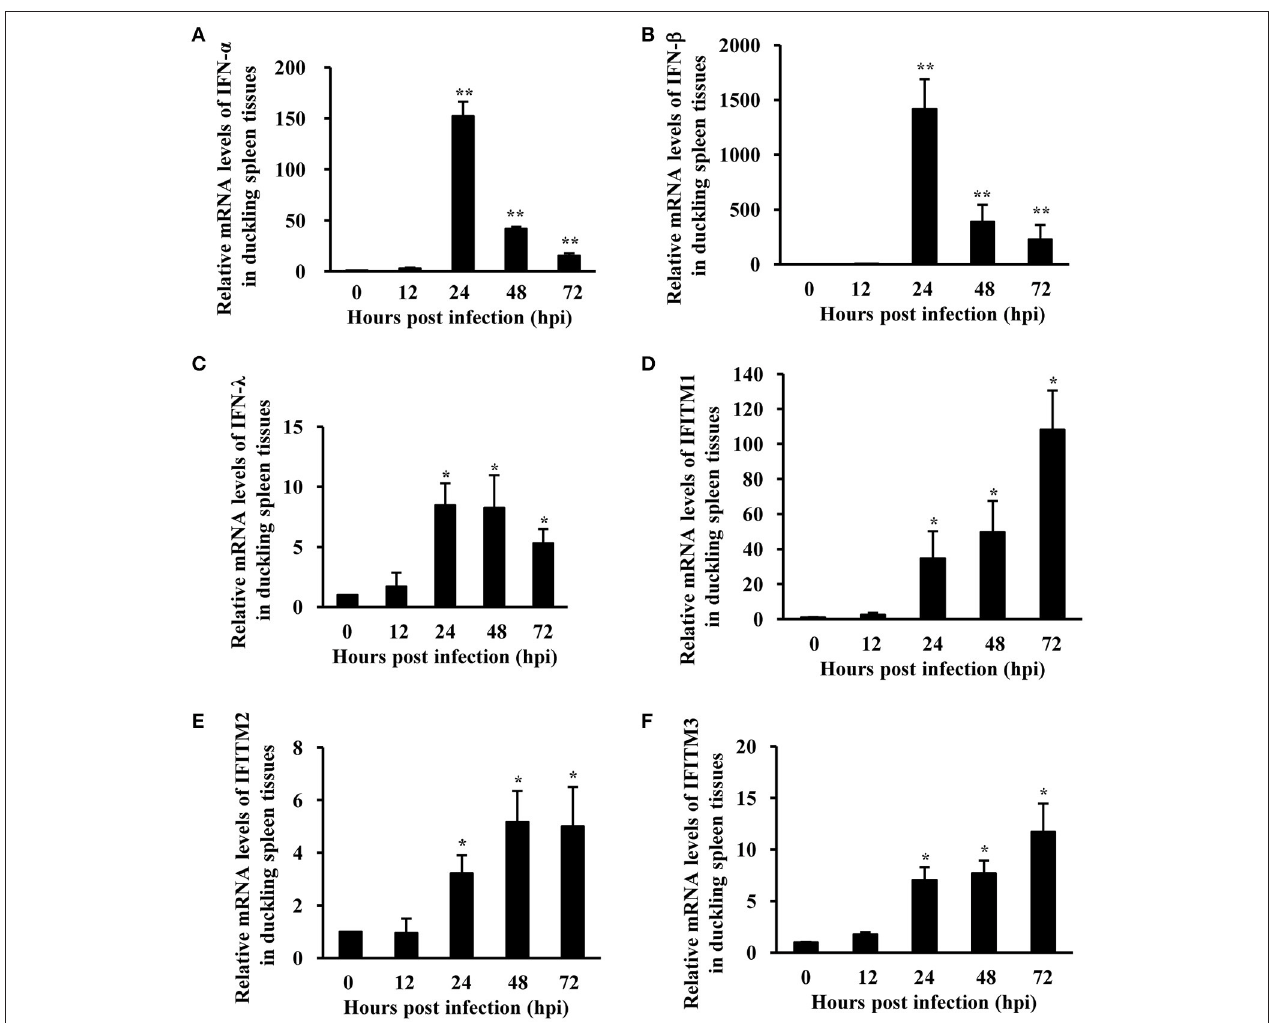
FIGURE 2 | Expression of IFNs and IFITM family is strongly upregulated in duck in response to ATMUV infection. Twenty five 7-day-old healthy mule ducklings were challenged by intramuscular injection with 4.0 × 10 5 ELD 50 of ATMUV in a volume of 0.4 mL per duckling. Three randomly selected ducklings were sacrificed at 0, 12, 24, 48, and 72 hpi, respectively. Their spleen tissues were collected for examination of IFN- α (A) , IFN- β (B) , IFN- λ (C) , and IFITM1, 2, 3 (D–F) mRNA expression using qRT-PCR. The mRNA levels were normalized to the endogenous β -actin level and the expression at 0 hpi was set to 1.0. Expression at 12–72 hpi was compared to its expression at 0 hpi. Each sample was analyzed in triplicate and the results are depicted as means ± SD ( n = 3). Statistical significance was determined by one tail Student’s t -test analysis. * P < 0.05, ** P <